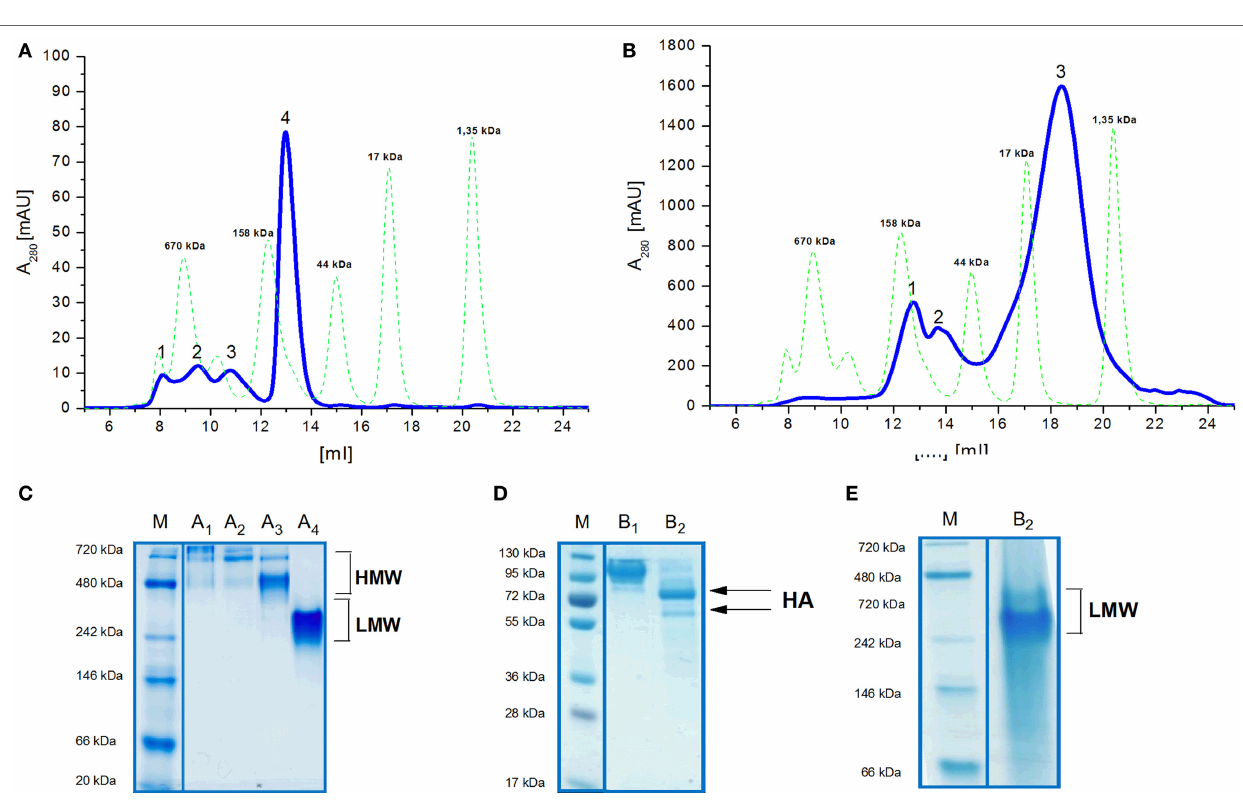
FigUre 3 | size exclusion chromatography (sec) (a,B) of h5 antigens on superdex 200 10/300 gl column and native Page analysis (c,e) of sec fractions . Chromatograms of the ion exchange chromatography–elution fractions (a,B) . Molecular weight (MW) standard is indicated by the green dotted line. Fractions of the H5 hm or H5 Man5 proteins were lyophilized separately and dissolved in water followed by 4 − 7% Native PAGE (c,e) . SEC fractions of the H5 Man5 protein were additionally analyzed on 4 − 12% SDS-PAGE (D) following Coomassie staining.